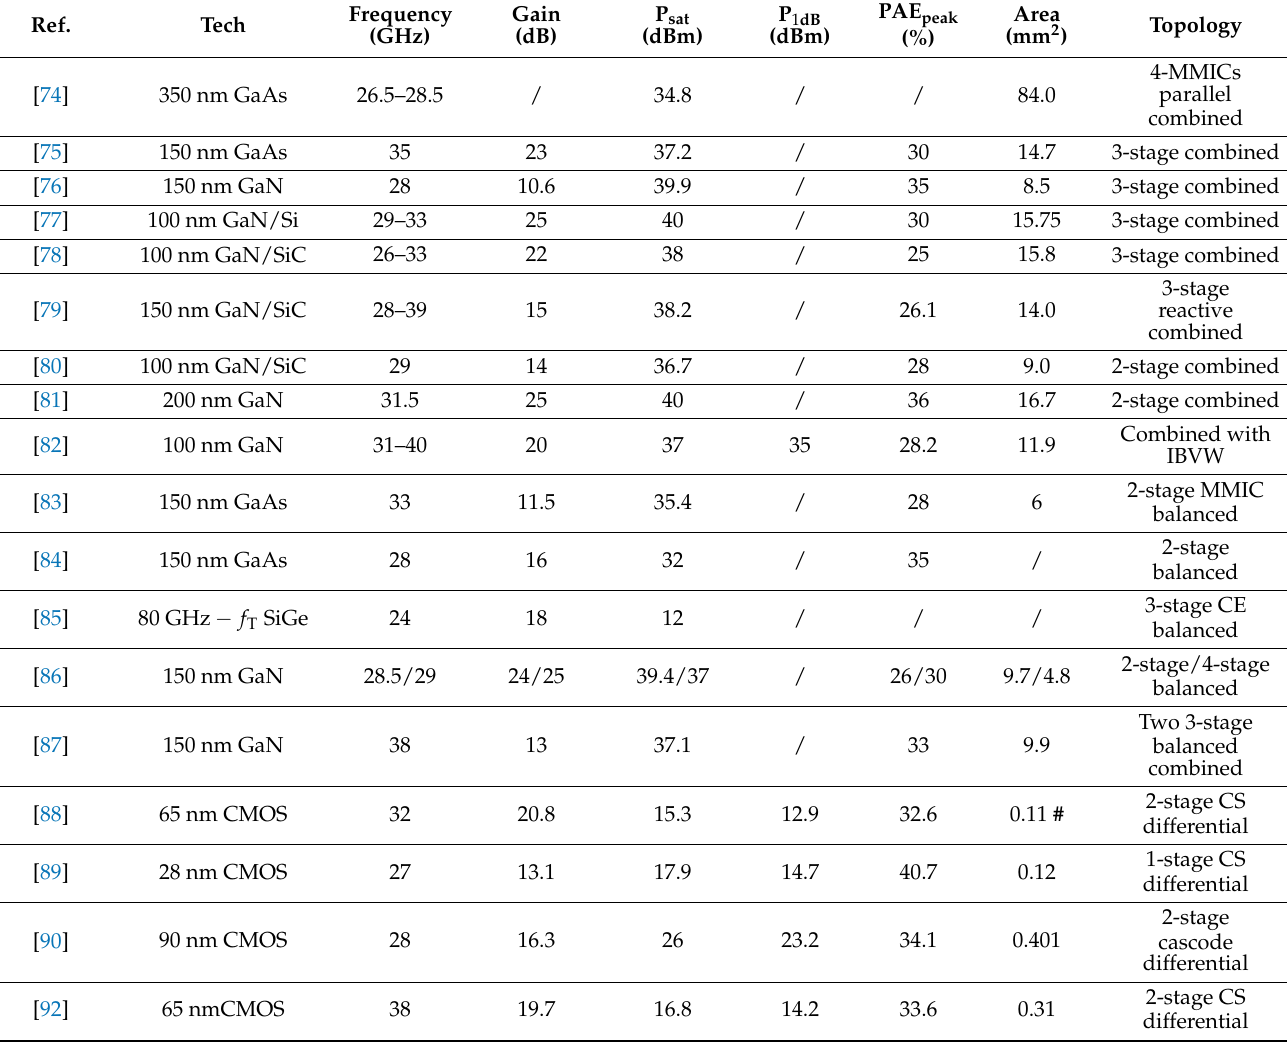
Table 4. Comparison of the measurement results with the power combining